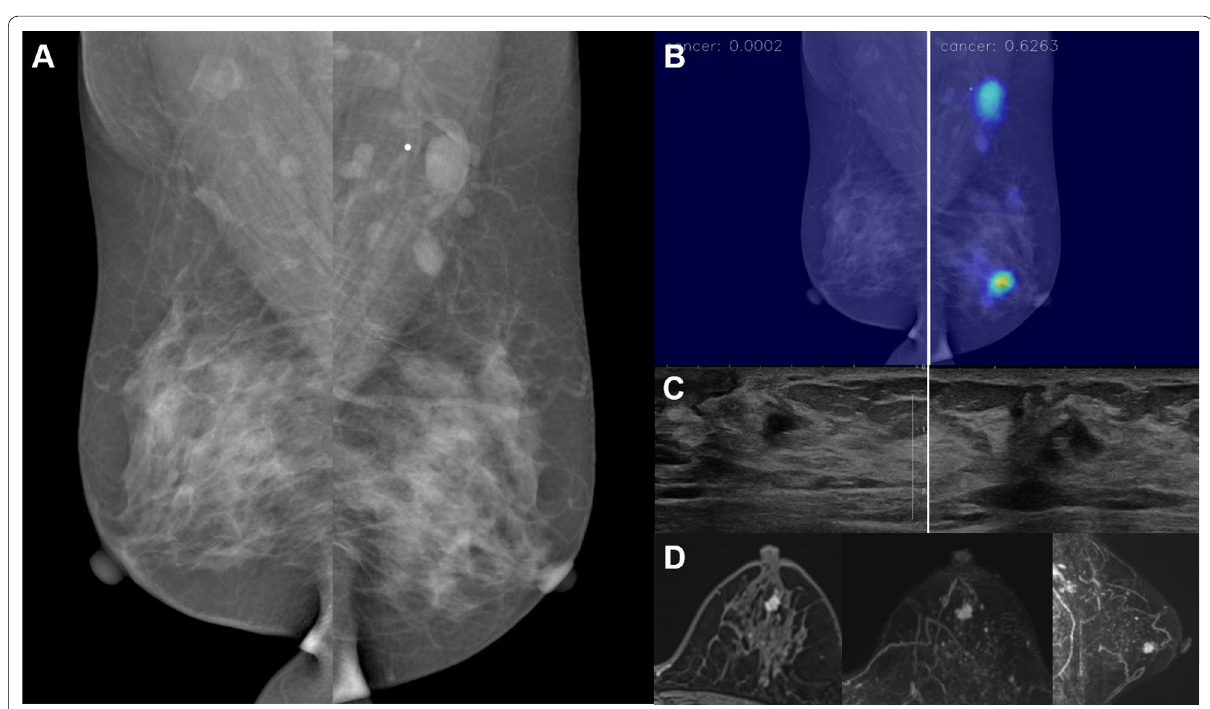
Fig. 3 A 50-year-old woman with invasive ductal carcinoma in the left breast. a A BB marker was attached at the left axilla, where an enlarged lymph node was noted. However, no abnormal finding was detected in both breasts by a radiologist. b – d AI highlighted a focal area in the mid-portion of the left breast, which correlated with the location of the cancer in US and MRI. The malignancy score of the cancer was 62.6. Histopathologic examination of core needle biopsy and fine-needle aspiration showed a low histologic grade invasive ductal carcinoma that was estrogen receptor-positive, progesterone receptor-positive, and human epidermal growth factor receptor-2-negative, with axillary lymph node metastasis. Left central lumpectomy was performed after neoadjuvant chemotherapy, and no residual invasive ductal carcinoma was